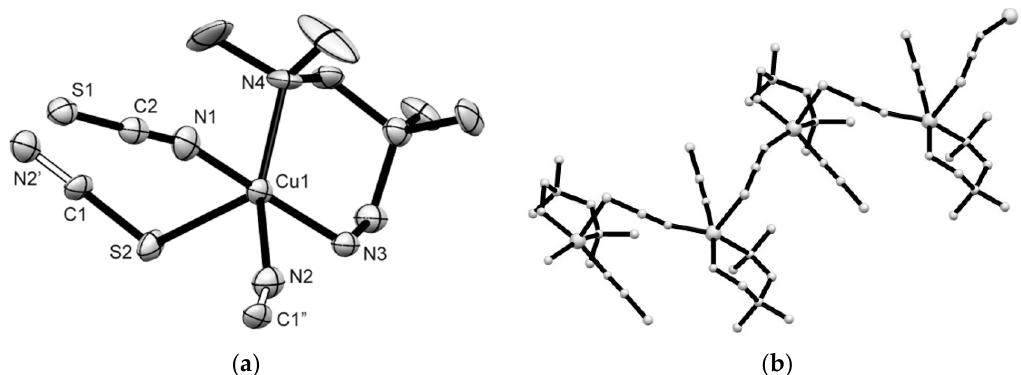
Figure 3. ( a ) Perspective view of the asymmetric unit and the Cu(II) coordination core of 3 (50% probability ellipsoids). Symmetry codes: (‘) x,1/2 − y,1/2+z; (“) x,1/2 − y, − 1/2+z. Selected bond distances (Å) and angles (°): Cu(1)-N(1) 1.955(6), Cu(1)-N(3) 1.987(5), Cu(1)-N(2) 2.024(5), Cu(1)-N(4) 2.112(5), Cu(1)-S(2) 2.6183(16); N(3)-Cu(1)-N(1) 170.08(19), N(4)-Cu(1)-N(2) 157.0(2). ( b ) View of a section of Table 2. Possible hydrogen bonds in crystal structures 1 – 5